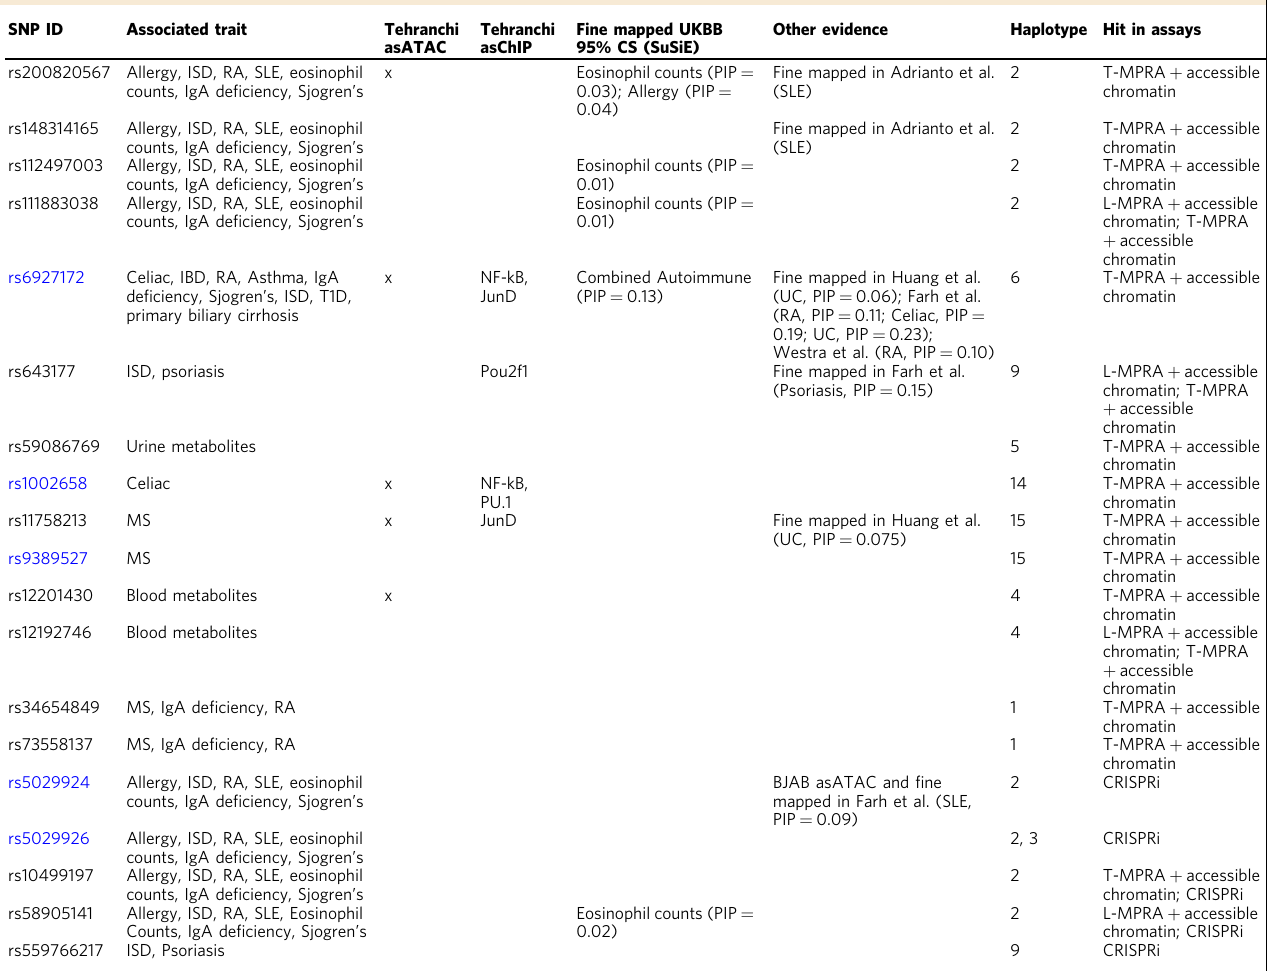
Table 1 Disease-associated variants positive for CRISPRi or chromatin accessibility with